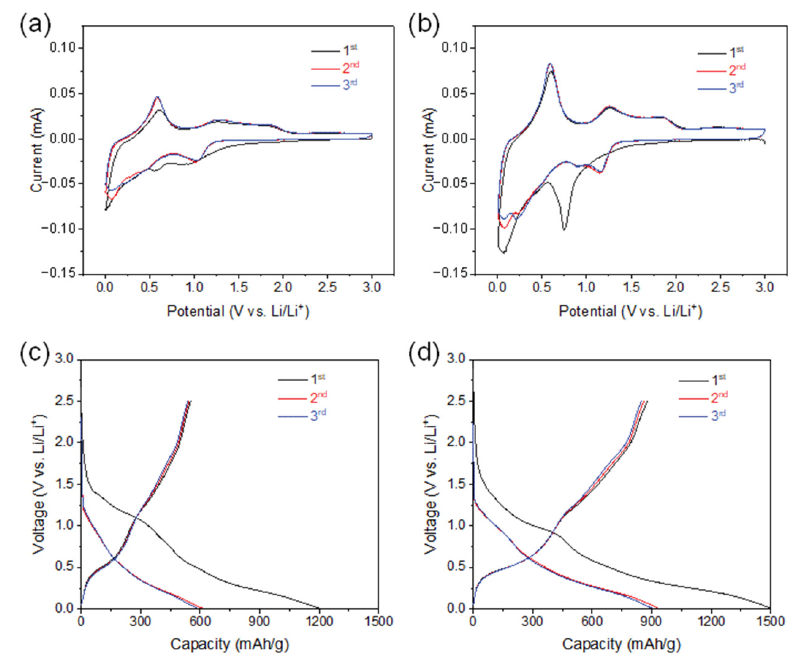
Figure 4. ( a , b ) CV curves in the potential ranging from 0.01 V to 3.0 V at a scan rate of 0.1 mV/s and ( c , d ) galvanostatic charge–discharge profiles at 100 mA/g of ( a , c ) 0SC and ( b , d ) 0.1SC. We measured lithium storage capacity for the SnO 2 @CNTF using galvanostatic charge/discharge at 100-, 200-, 500-, and 1000-mA/g rate conditions (see Figure 5). It should be noted that the discharge capacity described in this study was obtained by